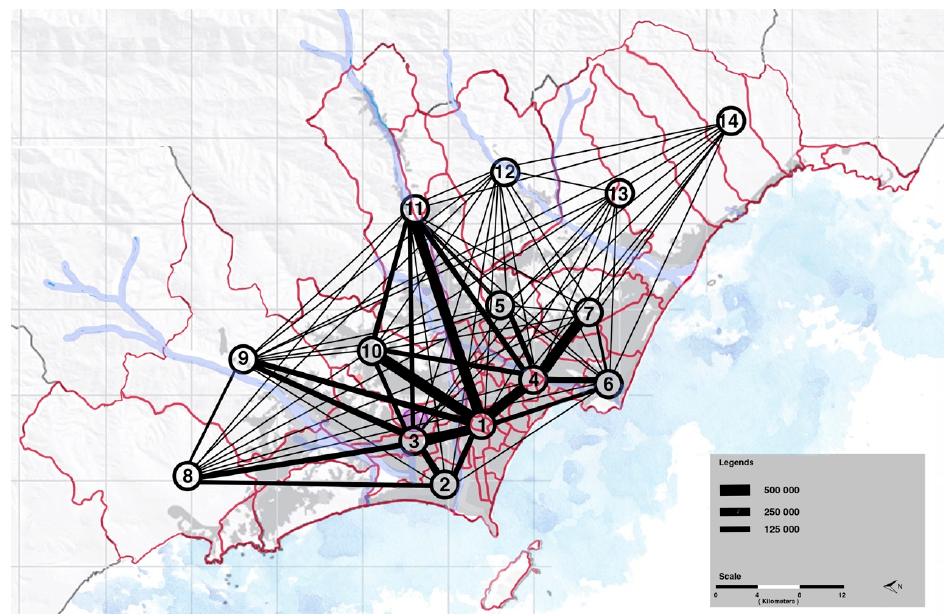
Source: Table redrawn by authors with data from reference [13].